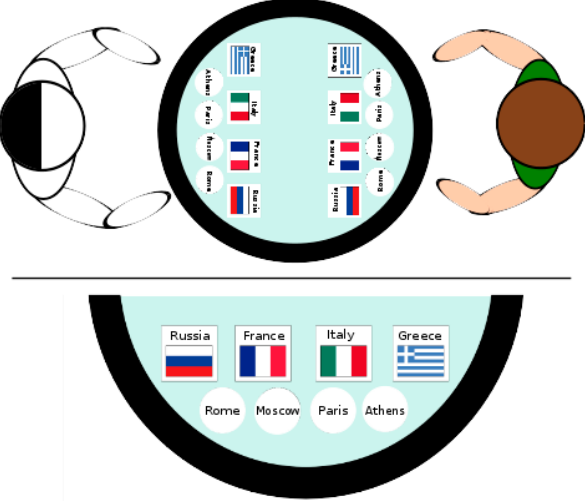
Figure 13: Example of the pairing game setup. The robot (left) and the participant (right) have a mirrored screen. The round objects on the bottom represent the capitals and the square objects on the top the countries with their flags. For each correct association, only the capital item disappears and only the remaining non-associated items are